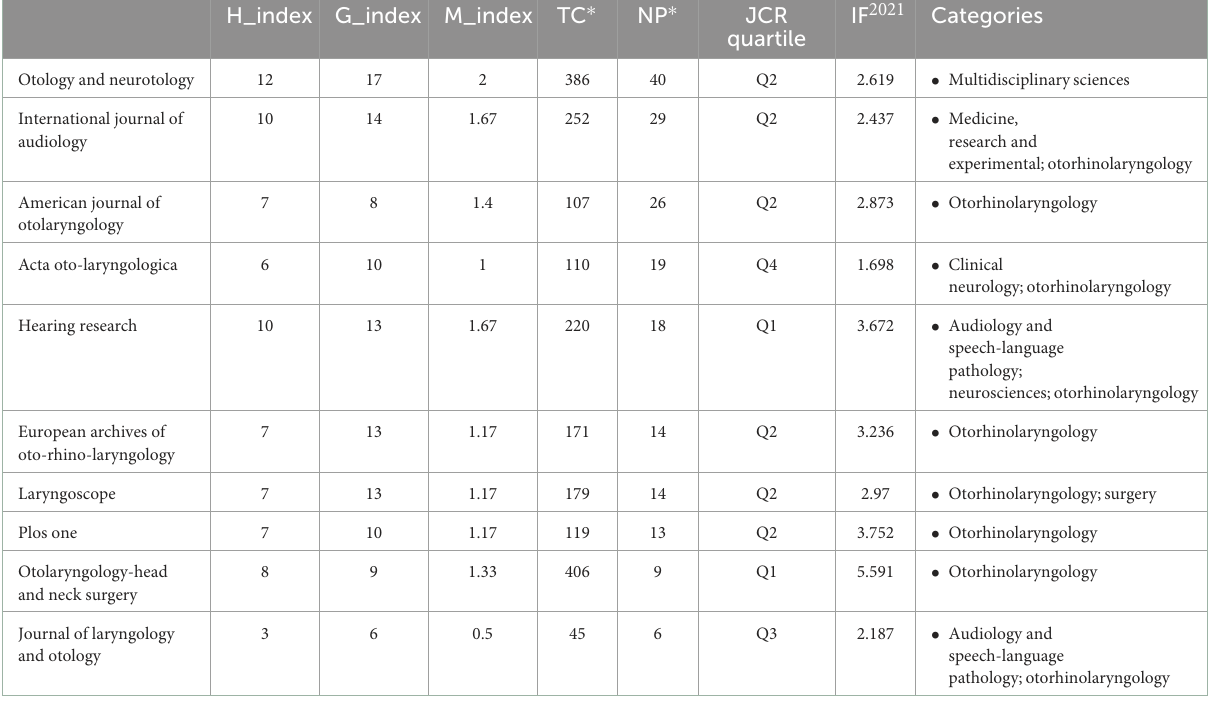
TABLE 1 The leading journals that published publications in the tinnitus treatment field.